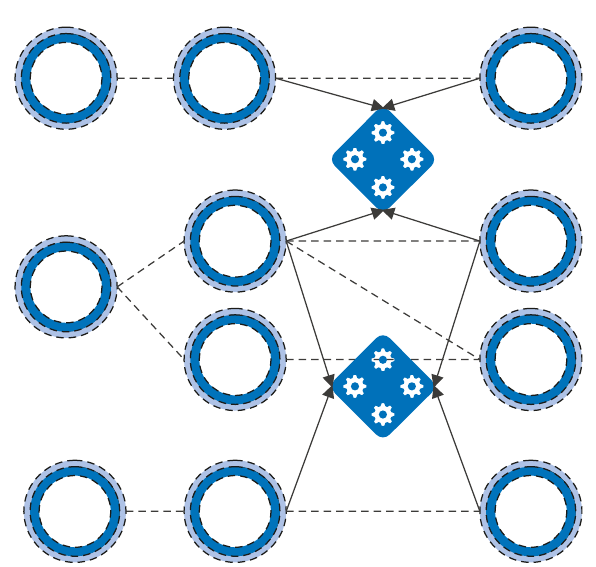
Figure 2: Planning